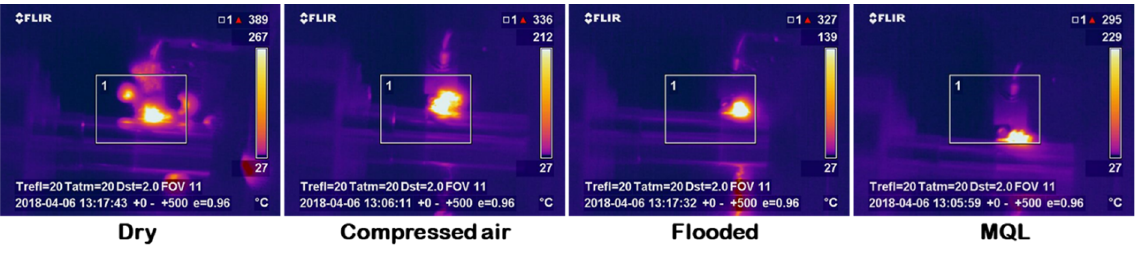
Figure 10. Infrared thermographs show the cutting temperature under different cooling lubrication methods at v = 51 m/min, f = 0.12 mm/rev.